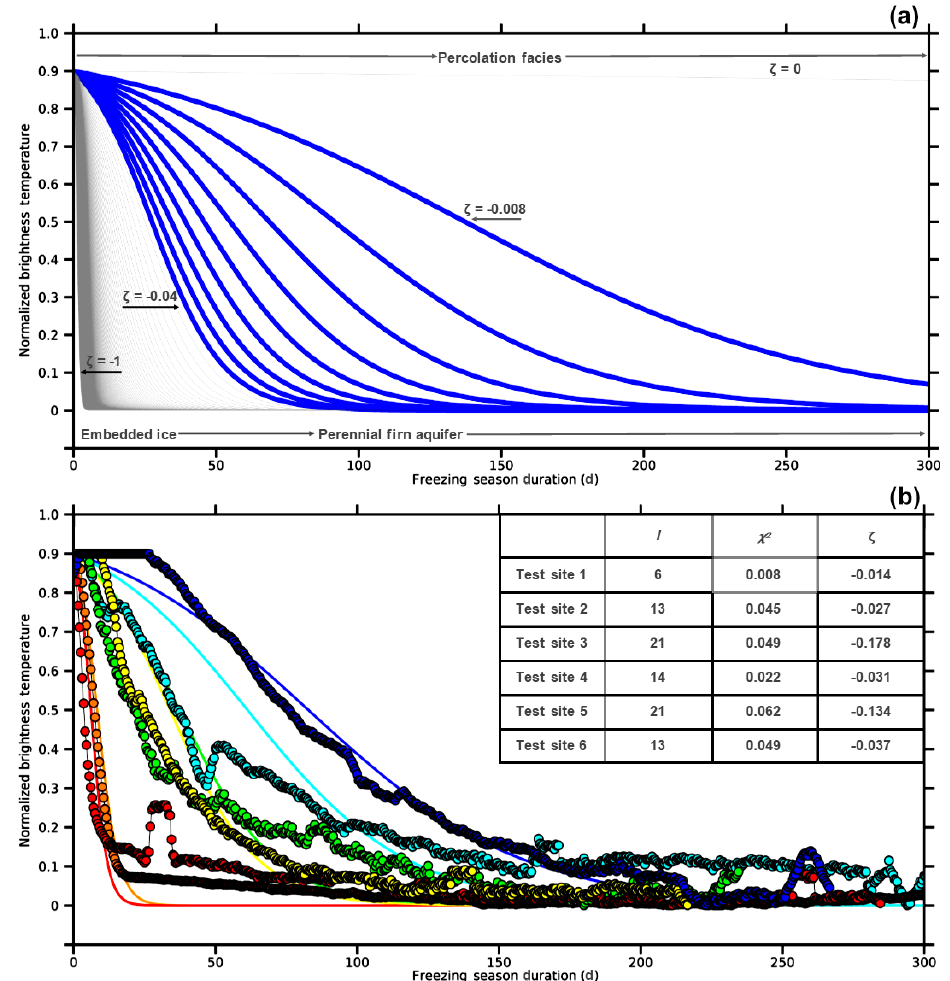
Figure 2. (a) Example set of simulated sigmoidal curves corresponding to the interval ζ ∈ [ − 1 , 0] which represents our model of expo- nentially decreasing L-band T B signatures over Greenland’s percolation facies. Blue lines correspond to the MCoRDS-derived calibration interval ζ ∈ [ − 0 . 04 , − 0 . 008] used to map Greenland’s perennial firn aquifers; grey lines correspond to the interval ζ ∈ [ − 1 , − 0 . 04 ) , which represents percolation facies areas where seasonal meltwater is refrozen and stored exclusively as embedded ice. (b) Examples of T B time series over test sites 1–6 that have been iteratively fit to the sigmoid function using the curve fitting algorithm. Test site 1 (blue circles and line); test site 2 (cyan circles and line); test site 3 (red circles and line); test site 4 (green circles and line); test site 5 (orange circles and line); test site 6 (yellow circles and line); associated curve fitting parameters (i.e., I,χ 2 ,ζ )(upper right